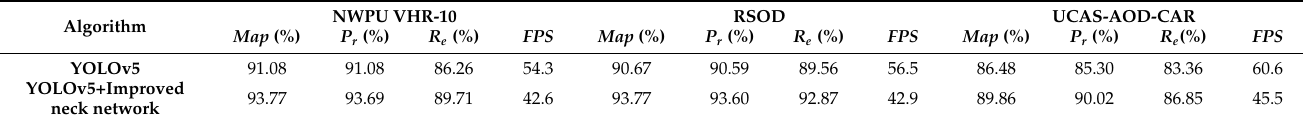
Table 6. Effects of the improved fusion neck network on three different datasets.